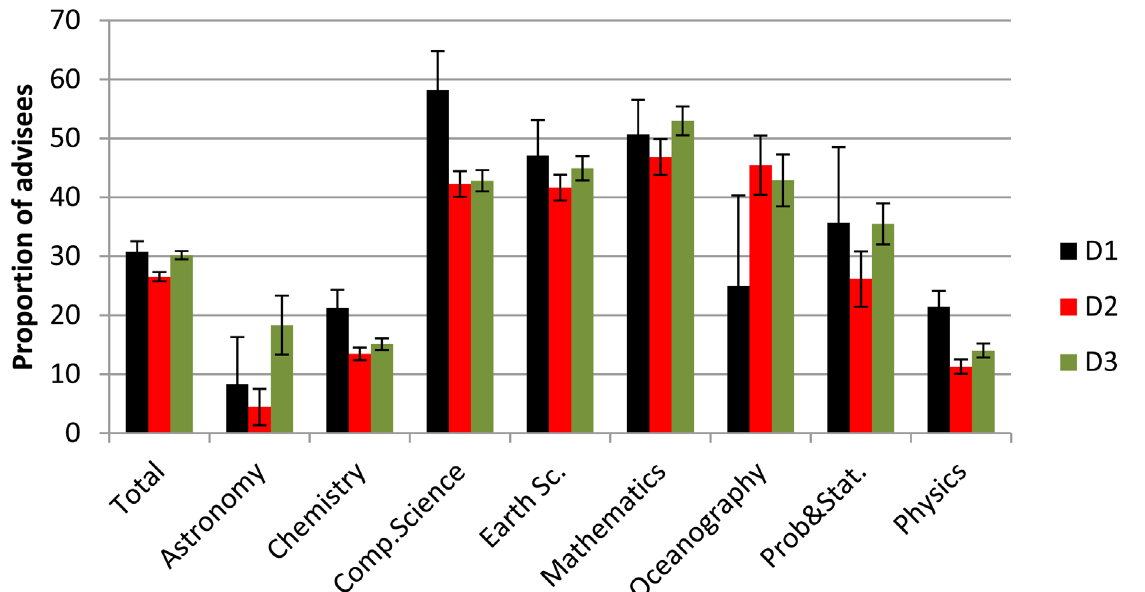
Fig 3. Proportion of advisees without A-A publications by